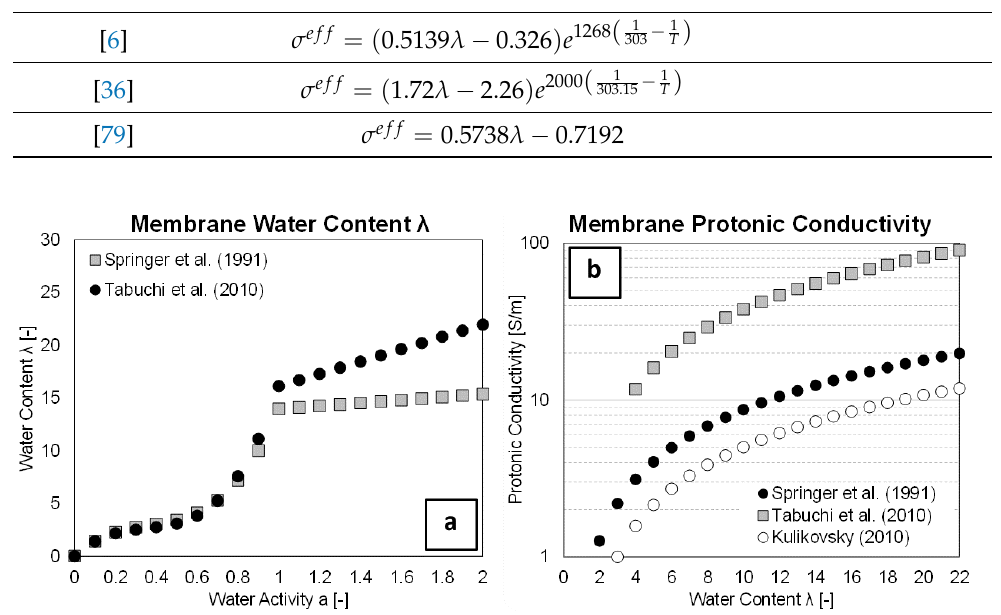
Table 10. Correlations for membrane protonic conductivity σ ef f in [S/m]. Ref.